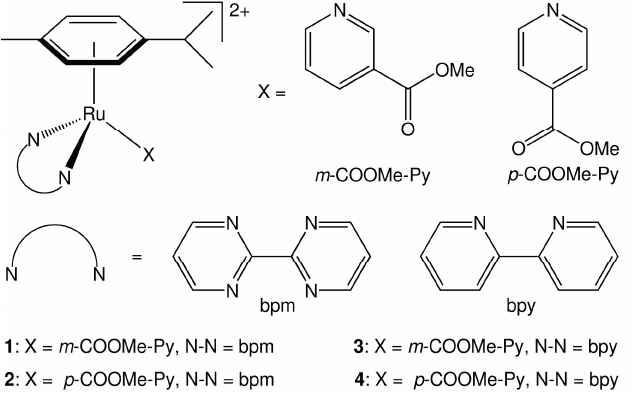
Figure 1. Structures of the Ru(II) arene complexes studied in this work.